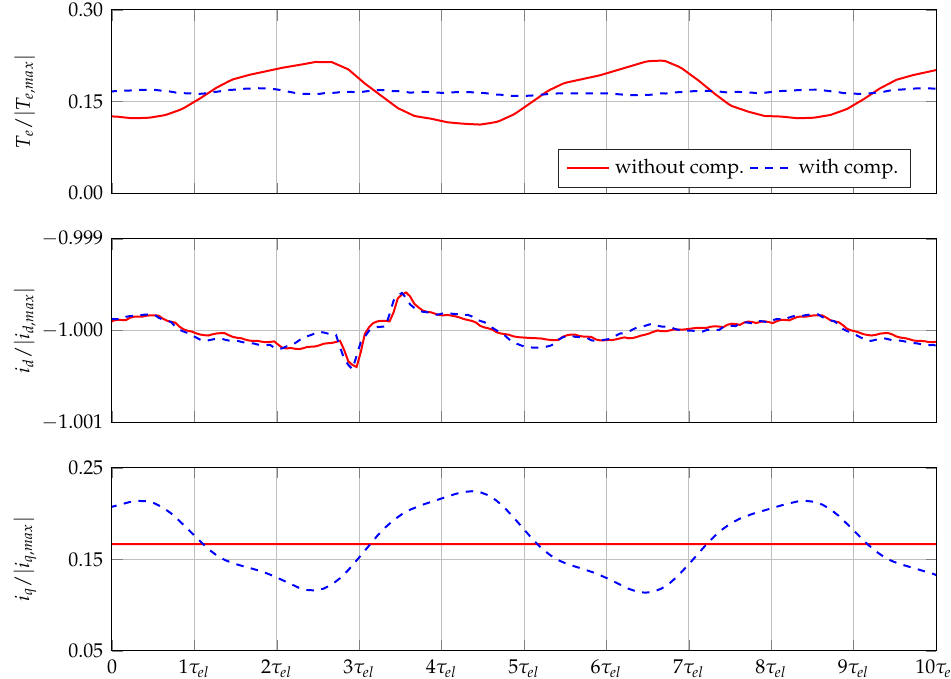
Figure 7. Generated torque and closed-loop controlled dq -currents with and without torque ripple compensation (note the different scaling of the i d and i q